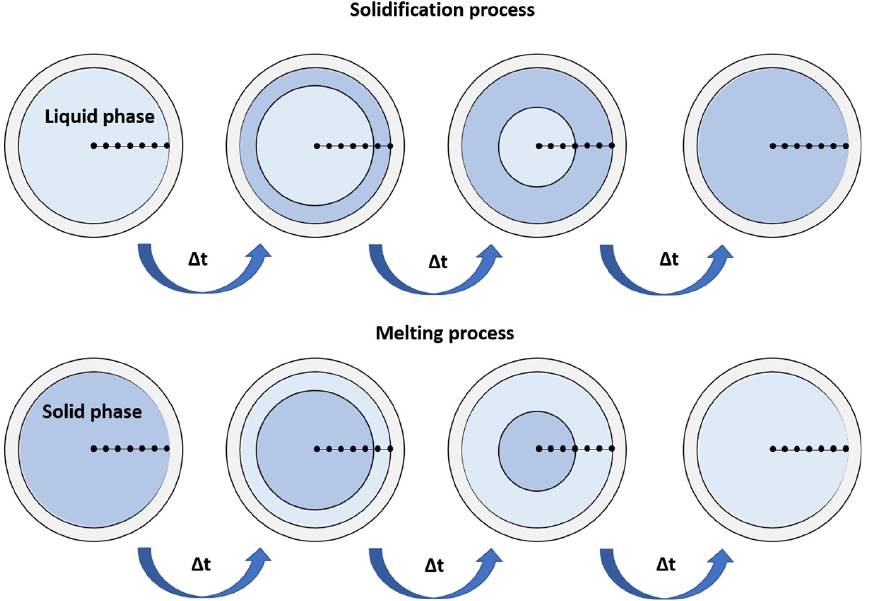
Figure 4. Numerical scheme of the solidification and melting processes within plastic spherical capsules.